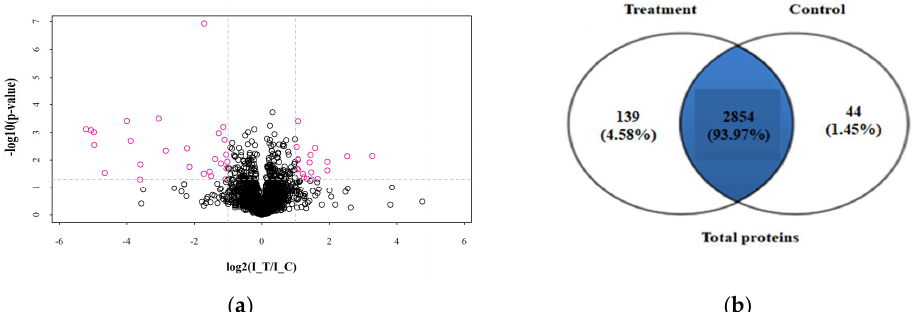
Figure 4. DEPs in different groups. ( a ) Volcano plot of DEPs, I-T was the treatment group. I-C was the control group. ( b ) Venn diagram of proteins in different groups.